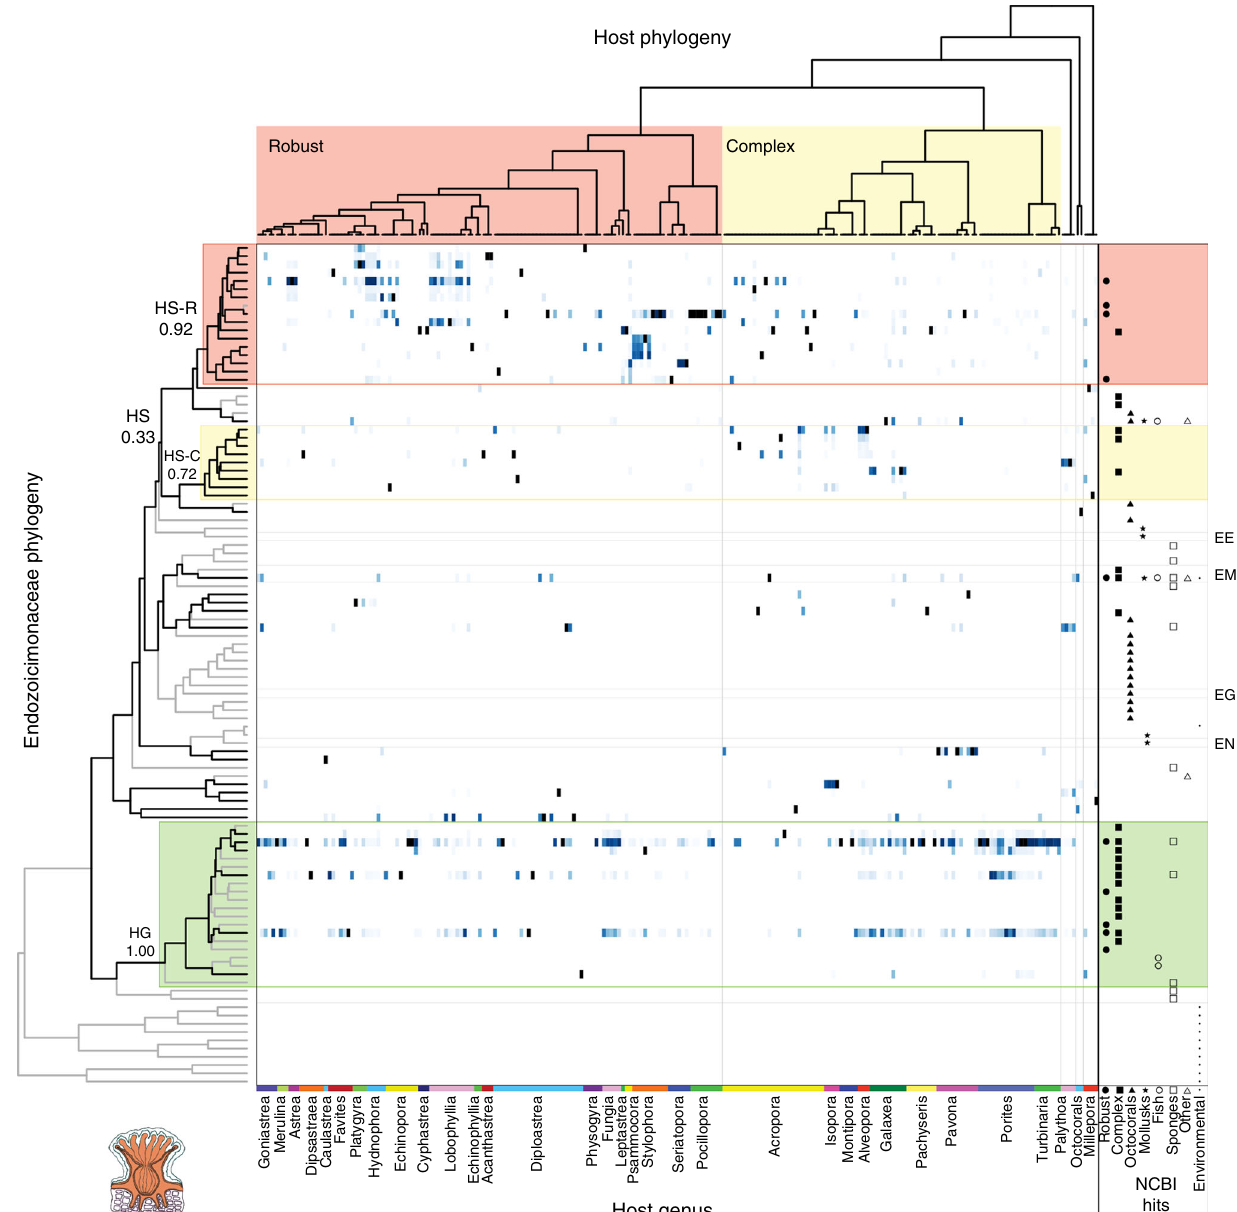
Fig. 4 Distribution of Endozoicomonas -like bacteria across coral hosts. The heatmap illustrates patterns of association between Endozoicomonas -like bacteria and coral hosts. Colored cells represent the relative abundance of Endozoicomonas -like bacterial sequences (out of the total abundance of Endozoicomonas - like bacteria) in each coral host, plotted on a scale from 0% (white) to 100% (dark blue). The x -axis is arranged by coral host phylogeny, which is shown at the top. The y -axis is arranged by the phylogeny of the most abundant Endozoicomonas -like bacterial sequences observed in host tissues, which is shown to the left (Bayesian posterior support values are shown for clades of interest). Clade HG (Host Generalist; green box) is prevalent in diverse species spanning both the Complex and Robust clades. Clades HS-R (Host-speci fi c: Robust; pink box) and HS-C (Host-speci fi c: Complex; yellow box) are composed of host- speci fi c Endozoicomonas -like lineages. On the right, the host organisms of each sequence variant ’ s perfect matches in NCBI ’ s nr database are shown. Cultured and named strains are identi fi ed with abbreviations (EE: Endozoicomonas elysicola , EM: Endozoicomonas montiporae , EG: Endozoicomonas gorgoniicola , EN: Endonucleobacter bathymodioli ). Sequences in clades HS-R and HS-C are consistently associated with Robust and Complex clade corals, respectively (see Supplementary Fig. 5 for more